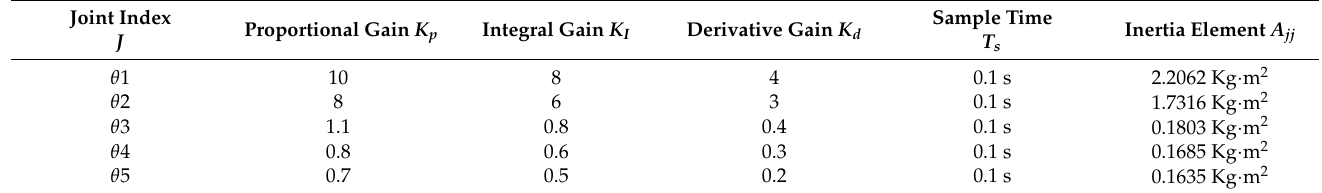
Table 4. Parameters of PID